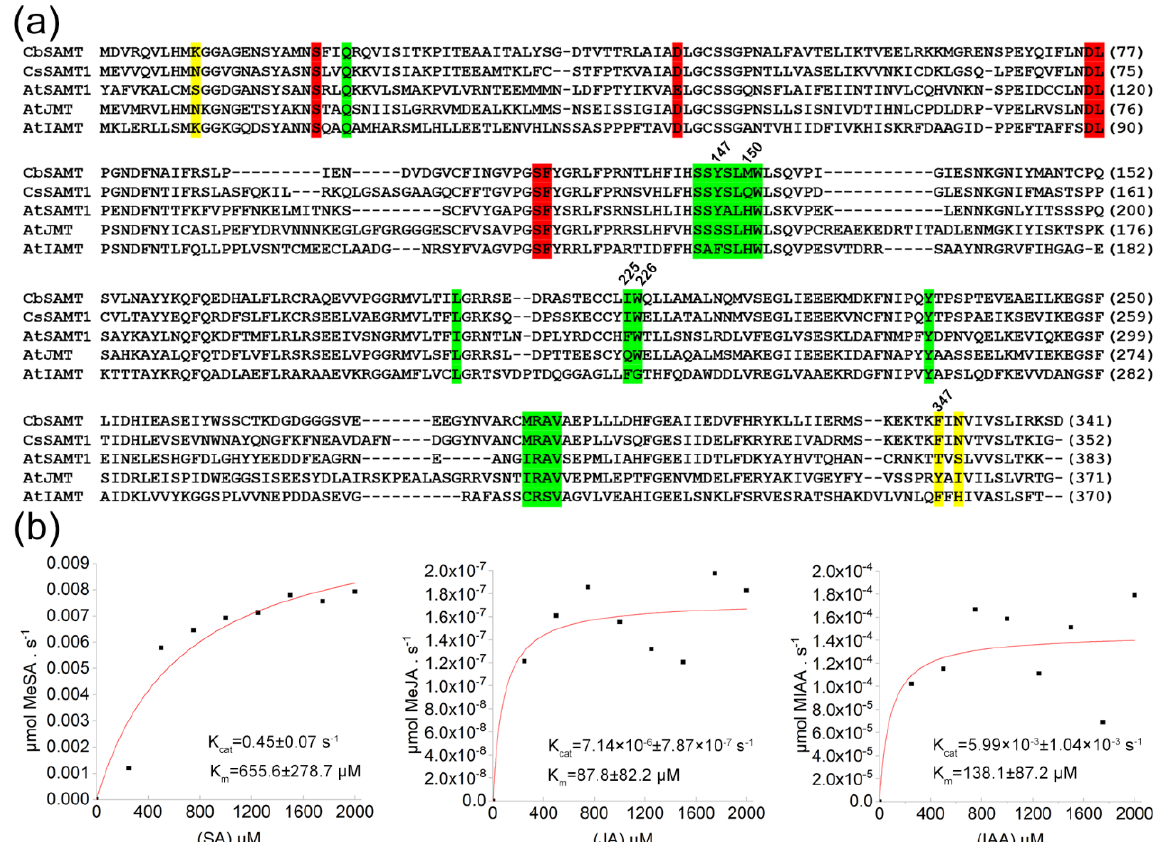
Figure 1. Characterization of the structural and kinetics of CsSAMT1. ( a ) Partial sequence alignment of representative Scheme 133053. AtSAMT1 is Arabidopsis SAMT1 (BT022049), AtJMT is Arabidopsis JMT (AY008435), AtIAMT is Arabidopsis IAMT (At5g55250), CsSAMT1 is Wanjincheng orange SAMT ( Citrus sinensis (L.) Osbeck, Cs1g24440). ( b ) The substrate specificities of purified recombinant CsSAMT1. 0, 250, 500, 750, 1000, 1250, 1500, 1750, and 2000 µM SA, JA and IAA were used to determine the biochemical activities of CsSAMT1. After 30 min of inoculation, the MeSA, MeJA and MeIAA contents in the reaction mixture were determined using enzyme-linked immunosorbent assay (ELISA) kits for MeSA, MeJA, and MeIAA (Jiweibio, Shanghai, China). The red line represents the nonlinear least-squares fit of the initial velocities versus the SA, JA or IAA concentration to the Michaelis-Menten equation. K cat was calculated by dividing the maximum velocity with the micromoles of the enzyme used. Errors indicate the standard deviations of the means of three tests. SA, salicylic acid; MeSA, methyl salicylate; JA, jasmonic acid; MeJA, methyl jasmonic acid; IAA, indole-3-acetic acid; MeIAA, methyl indole-3-acetic acid.